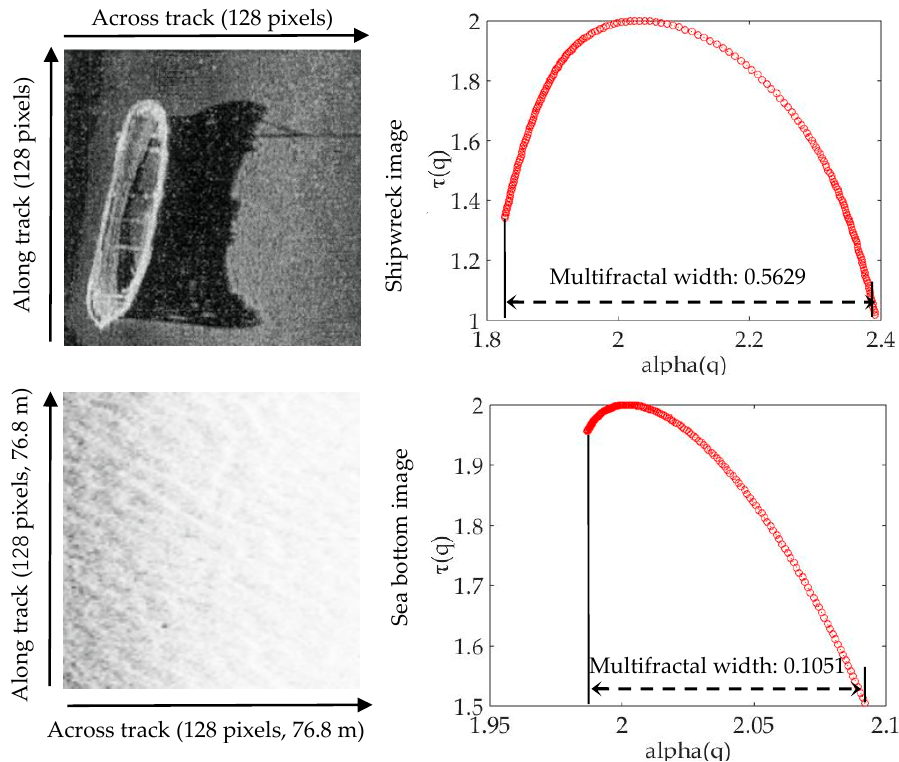
Figure 7. Comparison of the multifractal width of shipwreck and sea bottom image, the sea bottom image is intercepted from Figure 3.